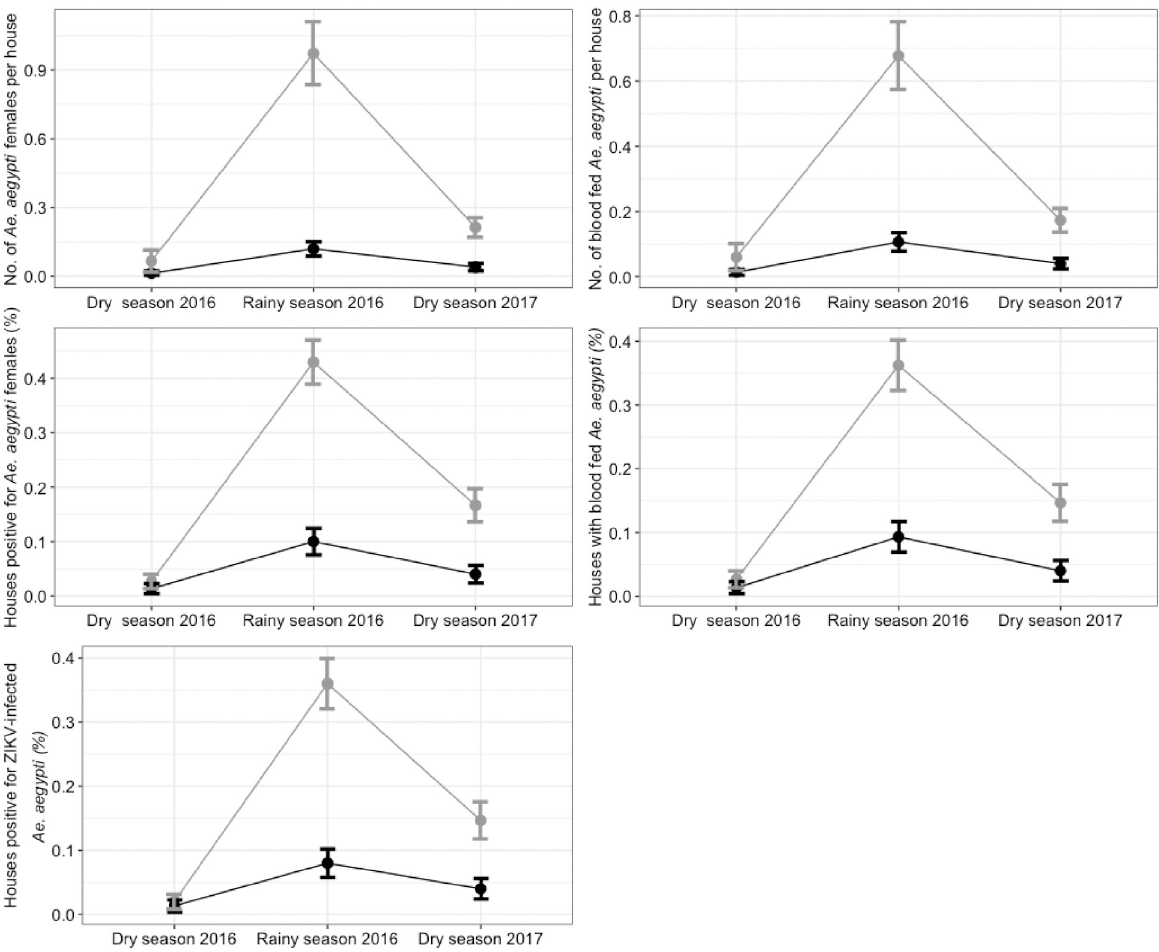
Fig 2. Entomological indicators of impact. Comparison between treated (black line) and untreated (gray line) arms of Ae . aegypti indoor adult based indicators for Merida, Mexico. The intervention (installation of ITS) was implemented between June-July 2016 (rainy season). Error bars show the standard error of the